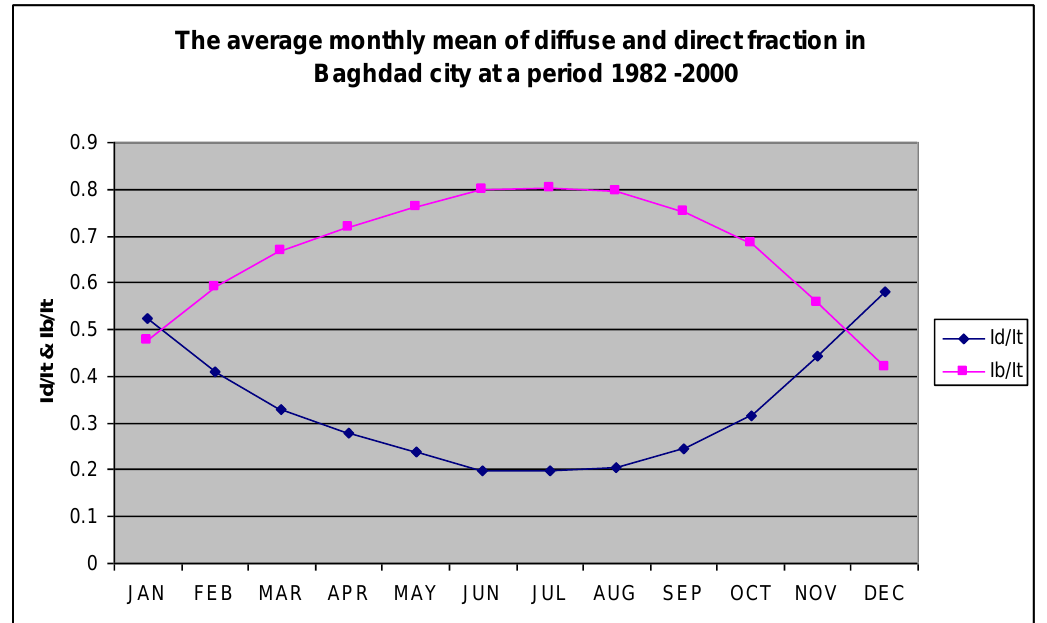
Fig. 6: Illustrated the monthly distribution between diffuse and direct fraction in Baghdad at